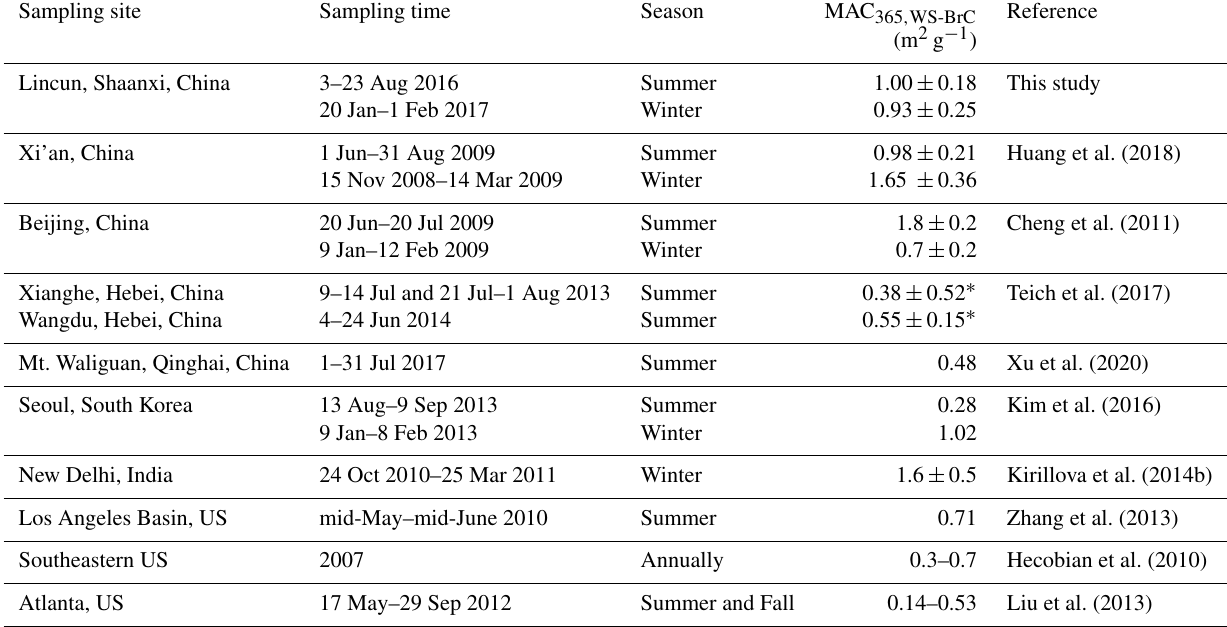
Table 2. Comparison of MAC 365 , WS-BrC values in the present study and those reported in earlier studies in China, India and the United States